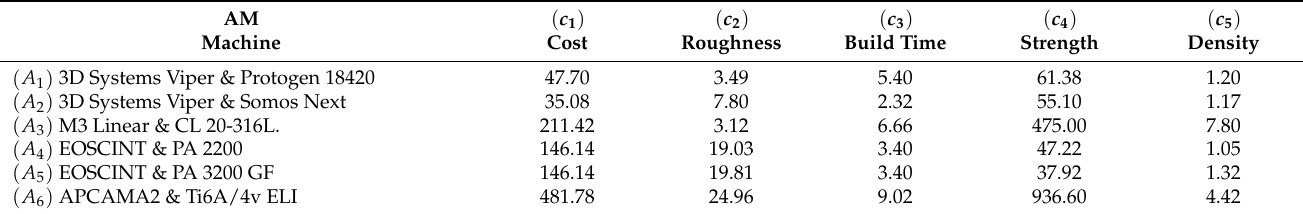
Table 8. Example 3 σ = ( 0.35, 0.4, 0.4, 0.4, 0.5 ) .